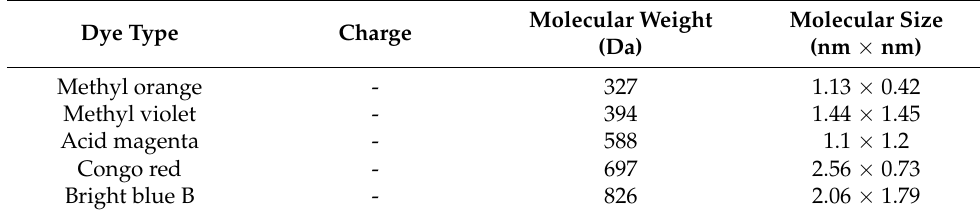
Table 1. The information of dyes used in this work.